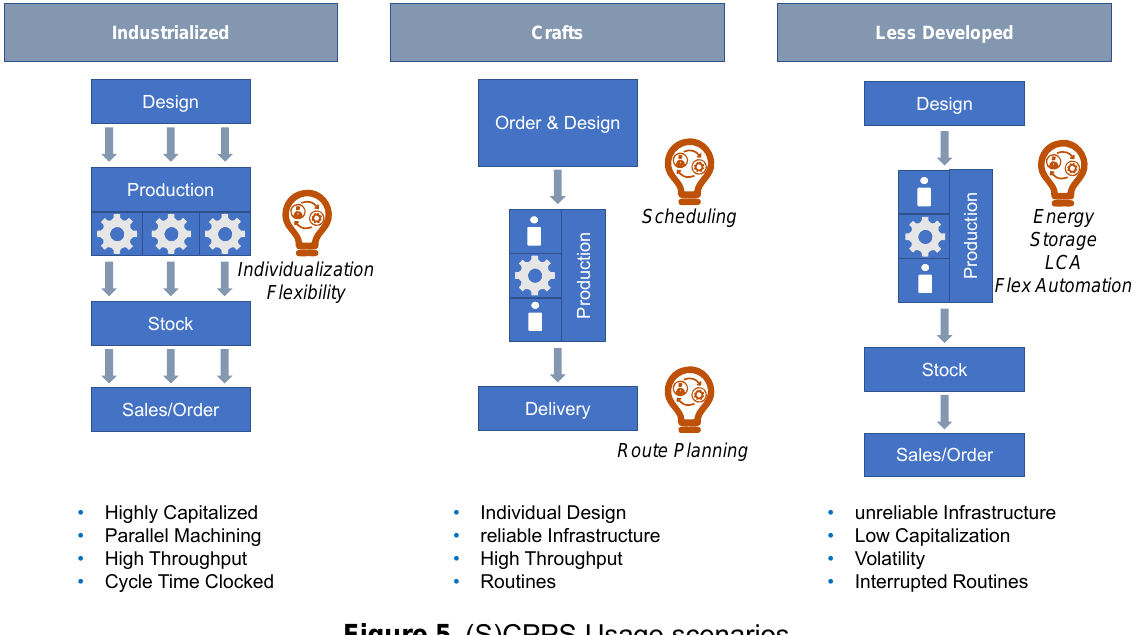
Figure 5 . (S)CPPS Usage